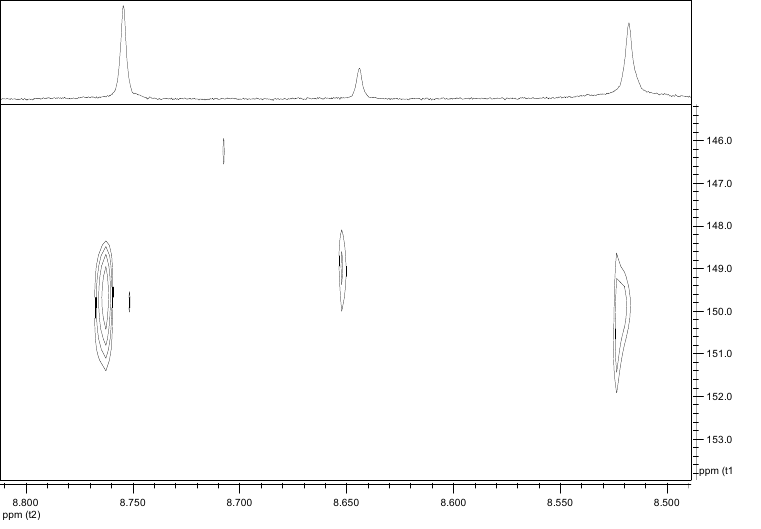
Figure 6. From the bottom to the top, 1 H NMR urine aromatic region of an HCV patient at TW4 stage (blue) and a control spiked with TR-COOH, T-CONH 2 , and T-COOH (red). Small variations in chemical shift can be attributed to the different ionic strengths and the small variation in pH in the urine sample. As a validation of this assignment, we recorded the reference spectra of each molecule (Supplementary Figure S1).